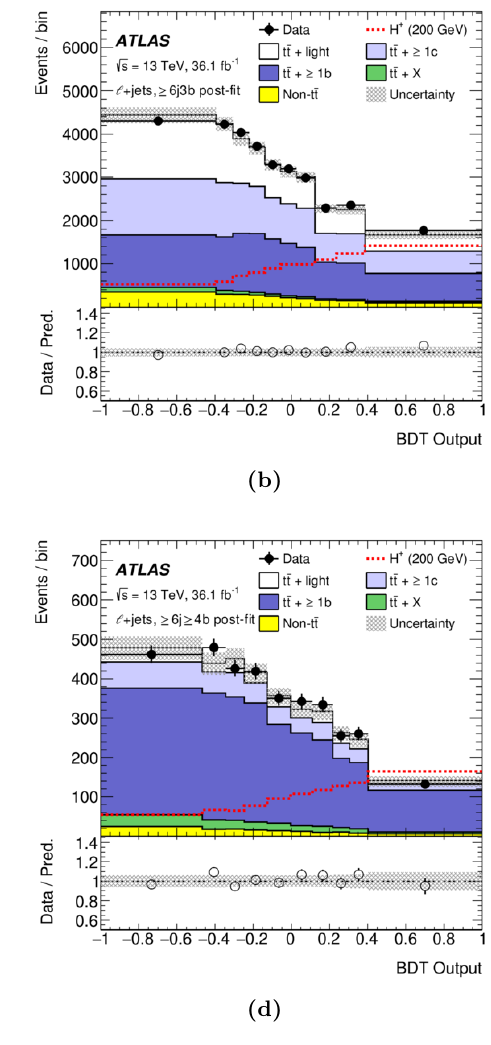
Figure 6. Distributions of the BDT output after the (cid:12)t to the data in the four SRs of the ‘ +jets (cid:12)nal state: (a) 5j3b, (b) (cid:21) 6j3b, (c) 5j (cid:21) 4b and (d) (cid:21) 6j (cid:21) 4b for the 200 GeV mass hypothesis. Each background process is normalised according to its post-(cid:12)t cross-section. The t (cid:22) t + X includes contributions from t (cid:22) tW , t (cid:22) tZ and t (cid:22) tH . The total prediction of the BDT distributions includes cases where the signal obtained from the (cid:12)t is negative. For this particular mass point the (cid:12)tted signal strength is (cid:22) = (cid:0) 0 : 4 (cid:6) 1 : 5 pb. The pre-(cid:12)t signal distribution is shown superimposed as a dashed line with arbitrary normalisation. The lower panels display the ratio of the data to the total prediction. The hatched bands show the post-(cid:12)t uncertainties.